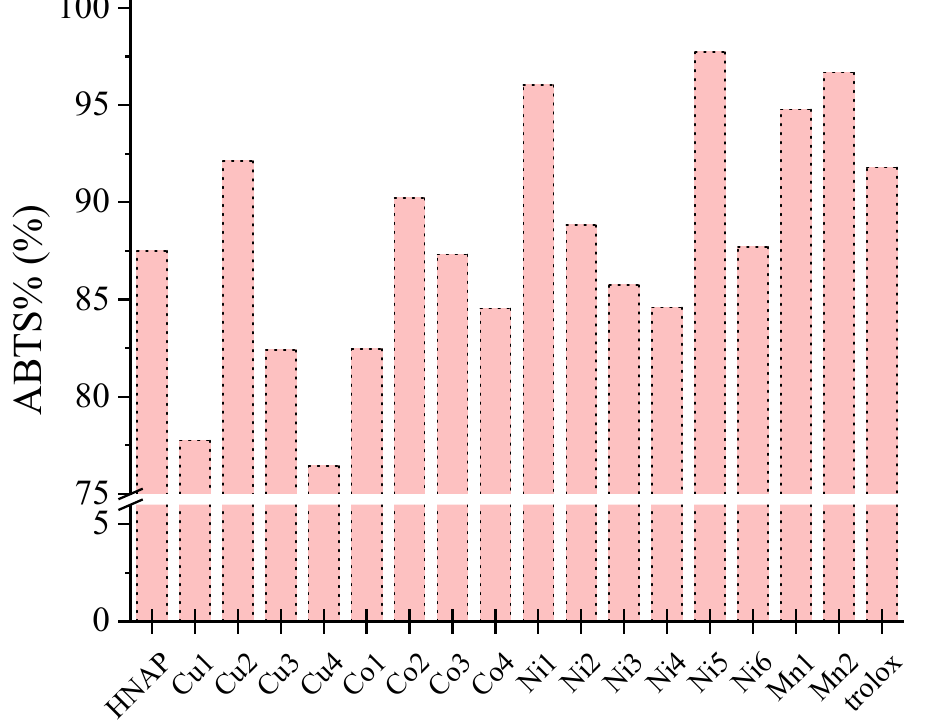
Figure 26. ABTS radicals’ scavenging activity (ABTS%) of naproxen and its reported complexes. (Codes of compounds: HNAP = naproxen; Cu1 = [Cu 2 (NAP) 4 (H 2 O) 2 ]; Cu2 = [Cu(NAP) 2 (py) 2 (H 2 O)];